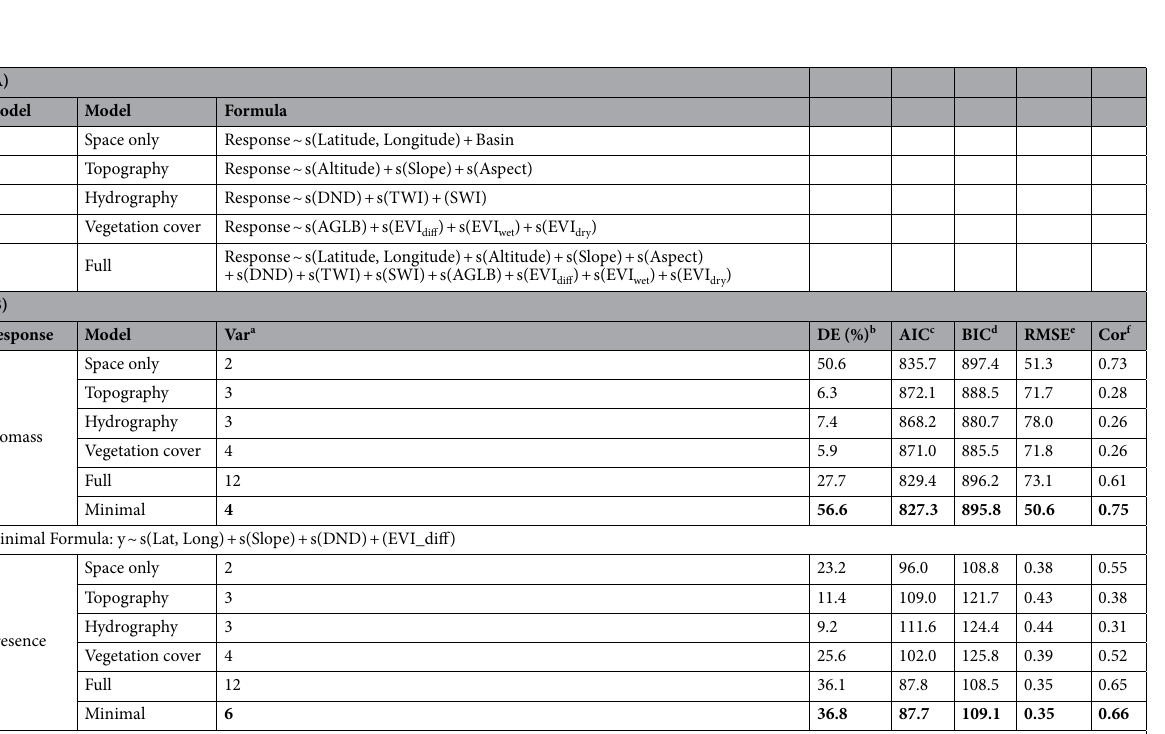
Figure 3. Spatial patterns in Vouacapoua americana fruit-fall. ( A ) dry fruit biomass (kg ha −1 ) recorded in 90 survey plots in the Amapá National Forest. Area of blue spheres proportional to biomass and crosses show plots without fallen fruits. Variograms show spatial autocorrelation patterns for biomass ( B ) and presence ( C ) in the 90 plots. Filled points show the estimated empirical variogram values, solid lines are the modelled variogram, and grey shading envelops representing complete spatial randomness obtained by permutation (n = 999 iterations) of the data values.